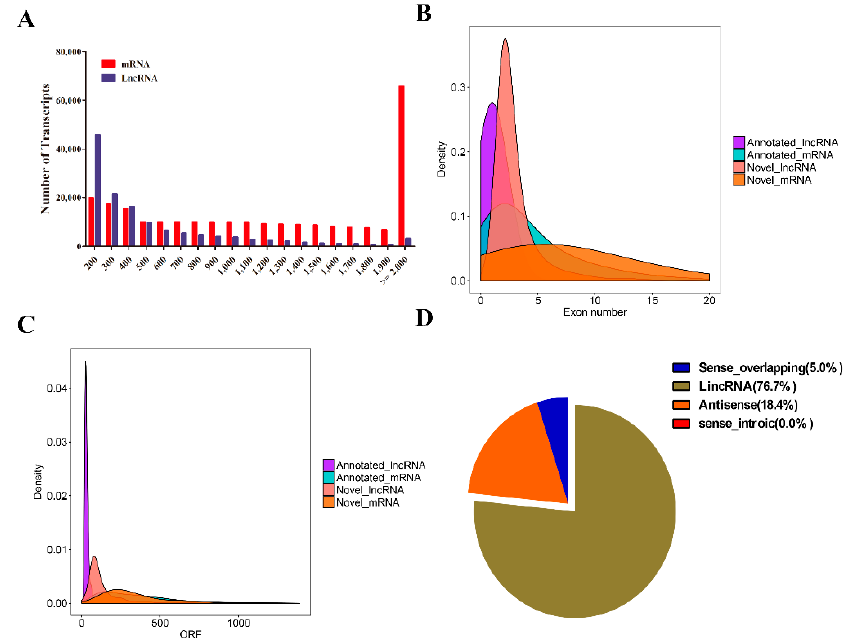
Figure 2. Characteristics of mRNA and lncRNA in Nicotiana benthamiana . ( A ), ( B ), and ( C ) Number of different lengths of lncRNAs and mRNAs in these transcripts, Exon numbers and open reading frame length density characteristics in the identified lncRNAs and mRNAs; ( D ) different types of lncRNAs were identified in the leaf of N. benthamiana , including intergenic lncRNAs, antisense lncRNAs (lncRNAs with exonic overlap with a known transcript), sense_overlapping lncRNAs (lncRNAs with generic exonic overlap with a known transcript), and sense_introic lncRNAs (lncRNAs with intronic and exon regions of a known